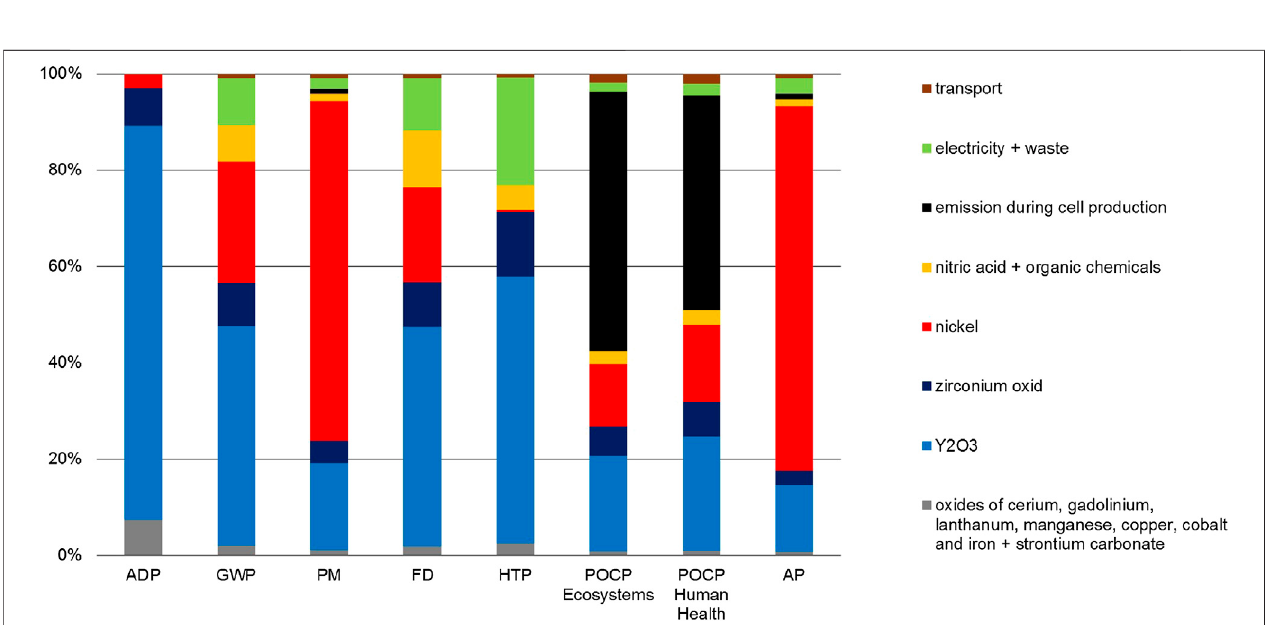
FIGURE 9 | Share of cell materials, energy demand and others on the total environmental impacts of single cell construction for HT-co-electrolysis.